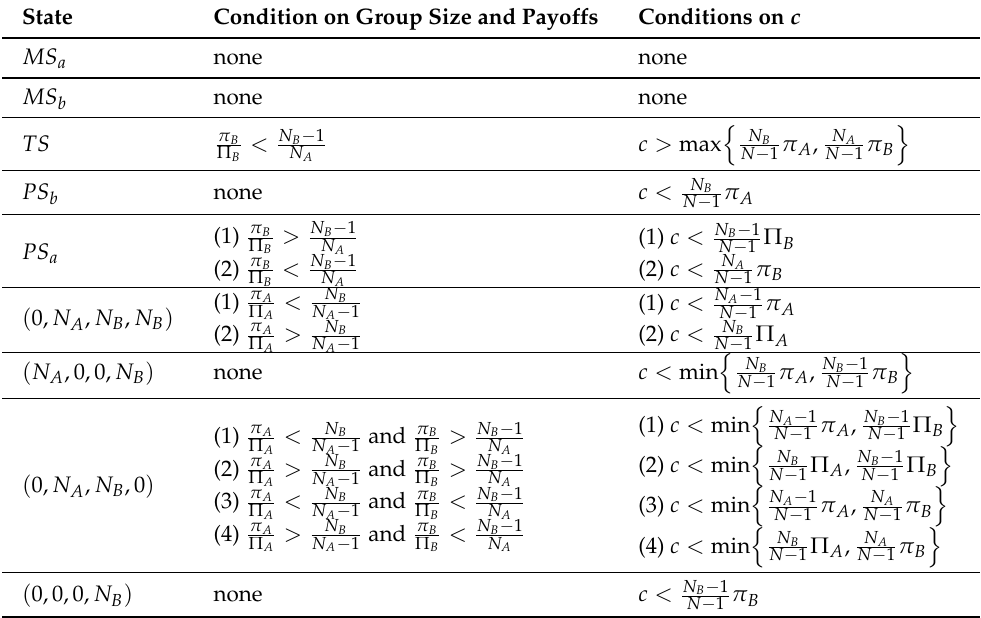
Table 4. Necessary and sufficient conditions for absorbing